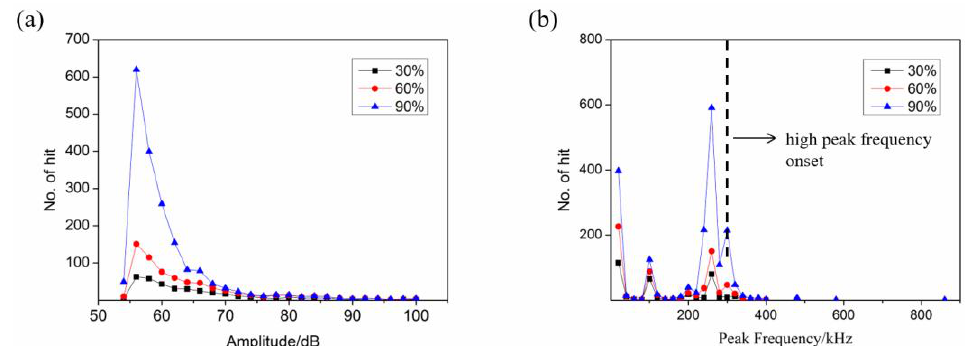
Figure 9. Progressive amplitude and peak frequency distribution at 30%, 60%, and 90% of the failure load. ( a ) amplitude distribution; ( b ) peak frequency